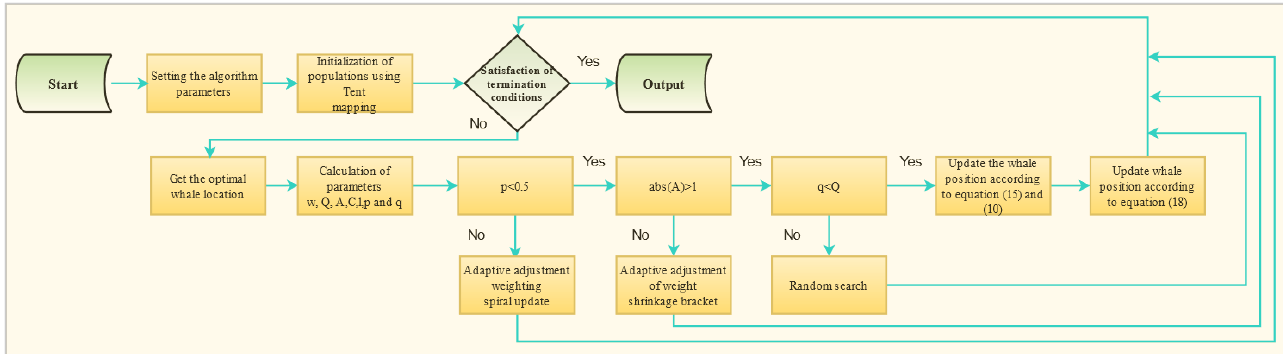
Figure 3. The flow chart of MWOA.